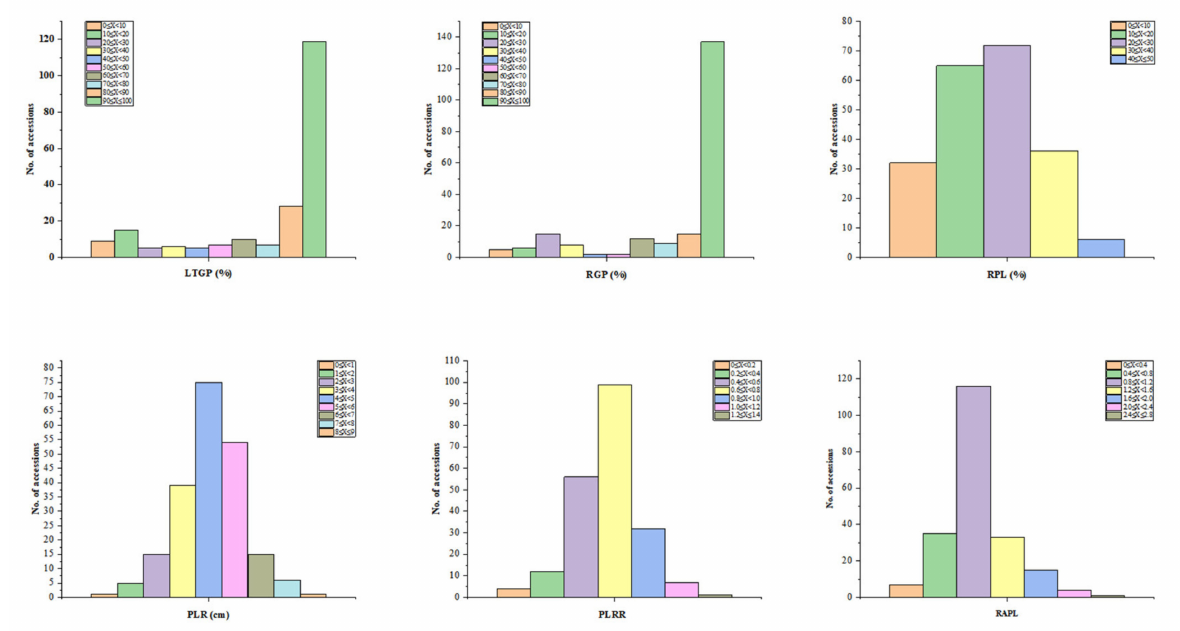
Figure 1. Distribution of six LTG indices (LTGP, RGP, RPL, PLR, PLRR and RAPL) in 211 rice accessions. The vertical axis in each subfigures represents the number of accessions, and each column on the horizontal axis represents the range of values. The LTGP and RGP distribution in 211 rice accessions was continuous while the remaining four indices are normally